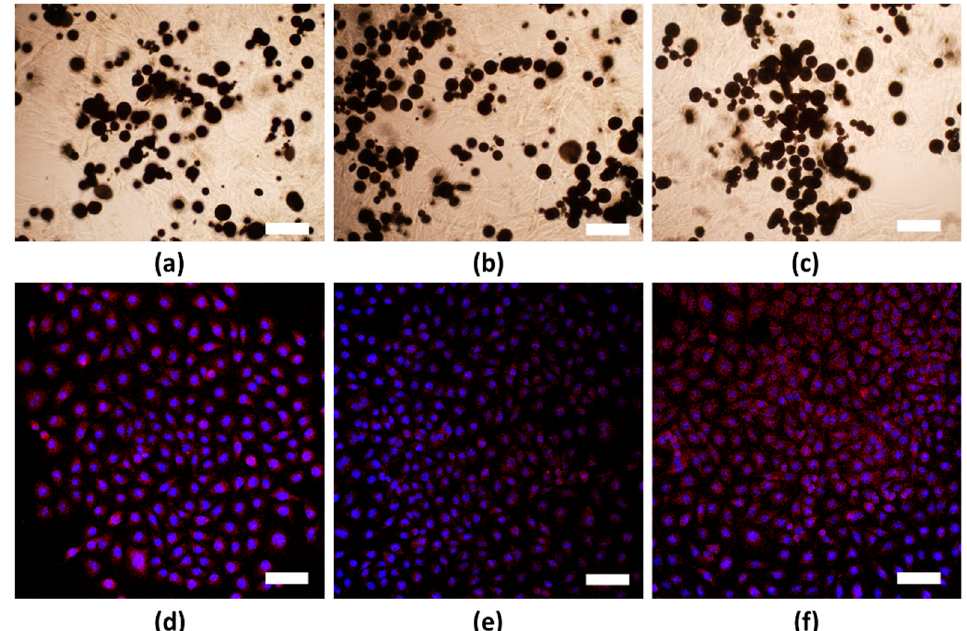
Figure 2. The VECs proliferation while cultured with composite hydrogels with different delivery systems at day 3. Optical microscope images of VECs in composite hydrogels with ( a ) delivery system I, ( b ) delivery system II, and ( c ) delivery system III. Meanwhile, the fluorescence images of VECs were obtained with ( d ) delivery system I, ( e ) delivery system II, and ( f ) delivery system III. The cell nucleus was represented by blue color, and cytoskeleton was represented by pink color. Scale bar: 25 μ m.